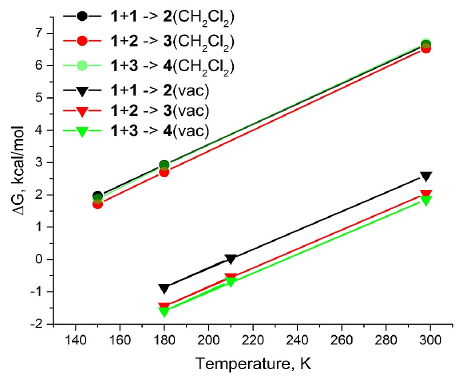
Figure 4. Calculated ∆ G of the proposed polycondensation reactions in dichloromethane and in vacuum.